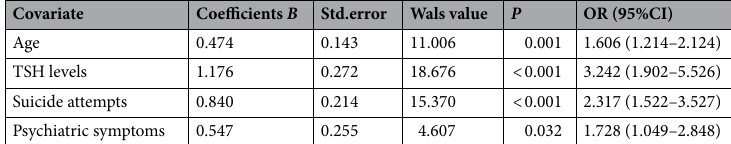
Table 4. Risk factors related to MetS by multivariate binary logistic